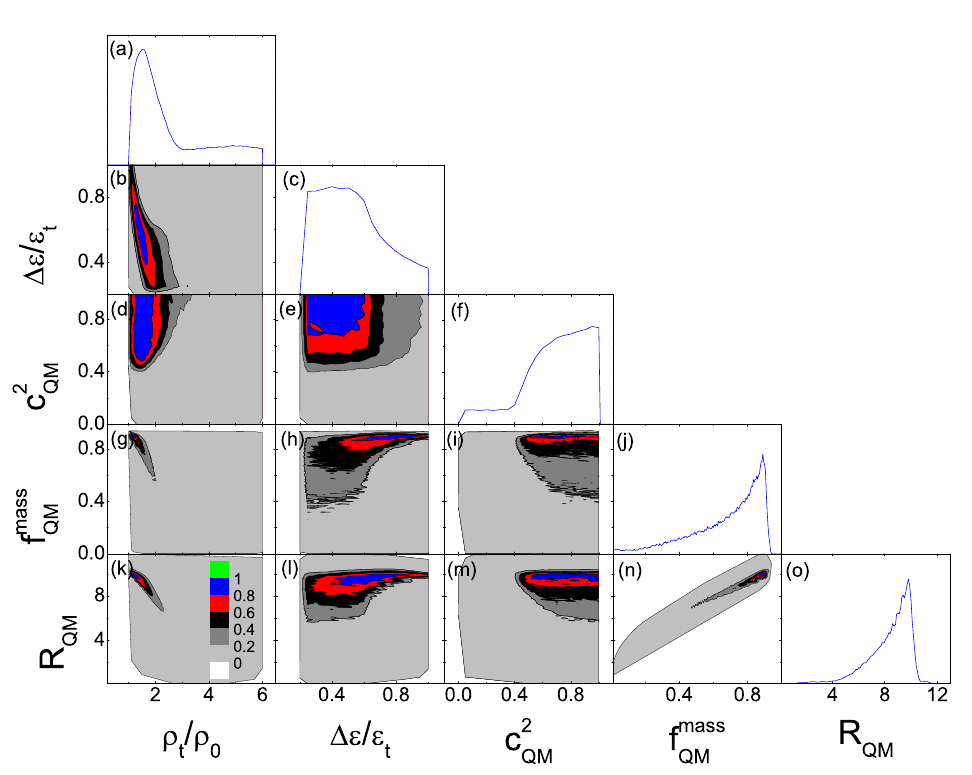
Figure 14. The subfigures along the diagonal are the posterior probability distribution functions (in arbitrary units) of the five quantities labeled (the three quark matter EOS parameters, as well as the fraction and radius of quark matter in hybrid neutron stars of mass 1.4 M (cid:12) ). See text for the definitions of each quantity shown. All off-diagonal subfigures are the correlations among the 5 quantities labeled. Taken from